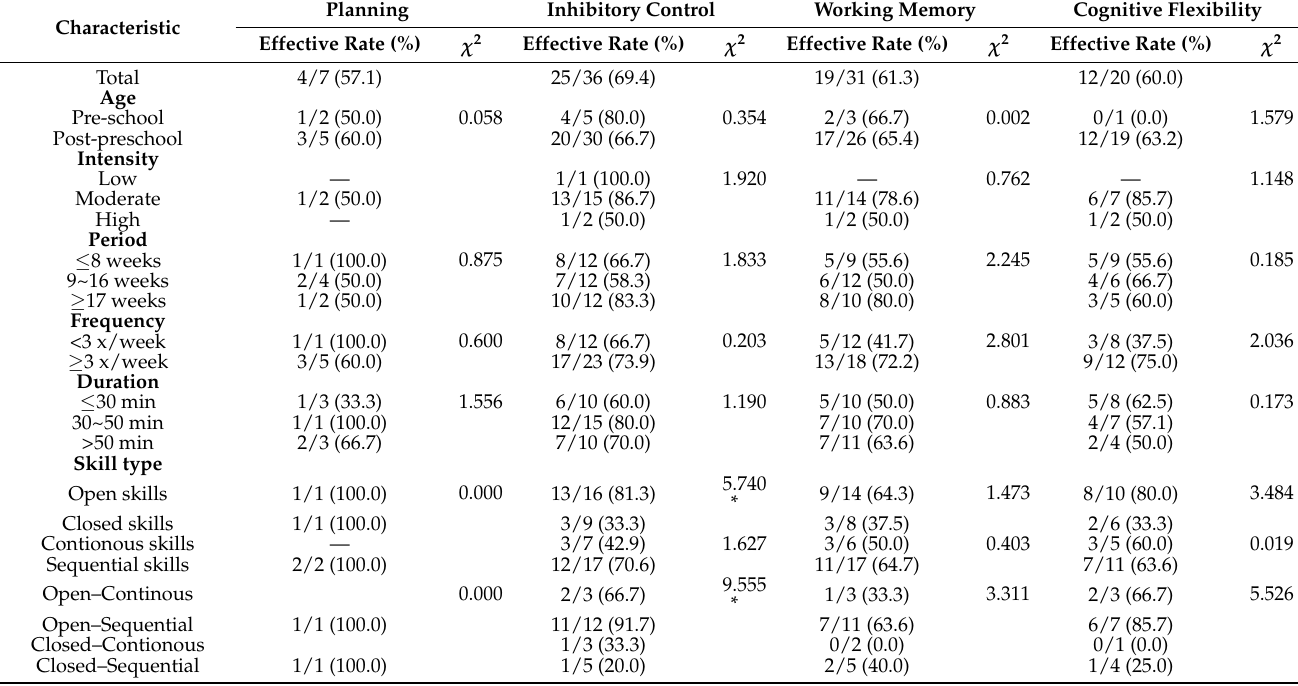
Table 5. Summary of intergroup comparisons of long-term intervention